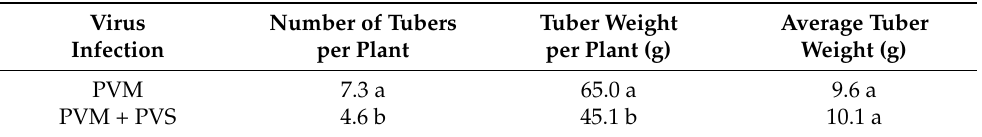
Table 8. Mini tuber yield components of R1 clones produced from microtubers, as affected by the sanitary status of the plants.